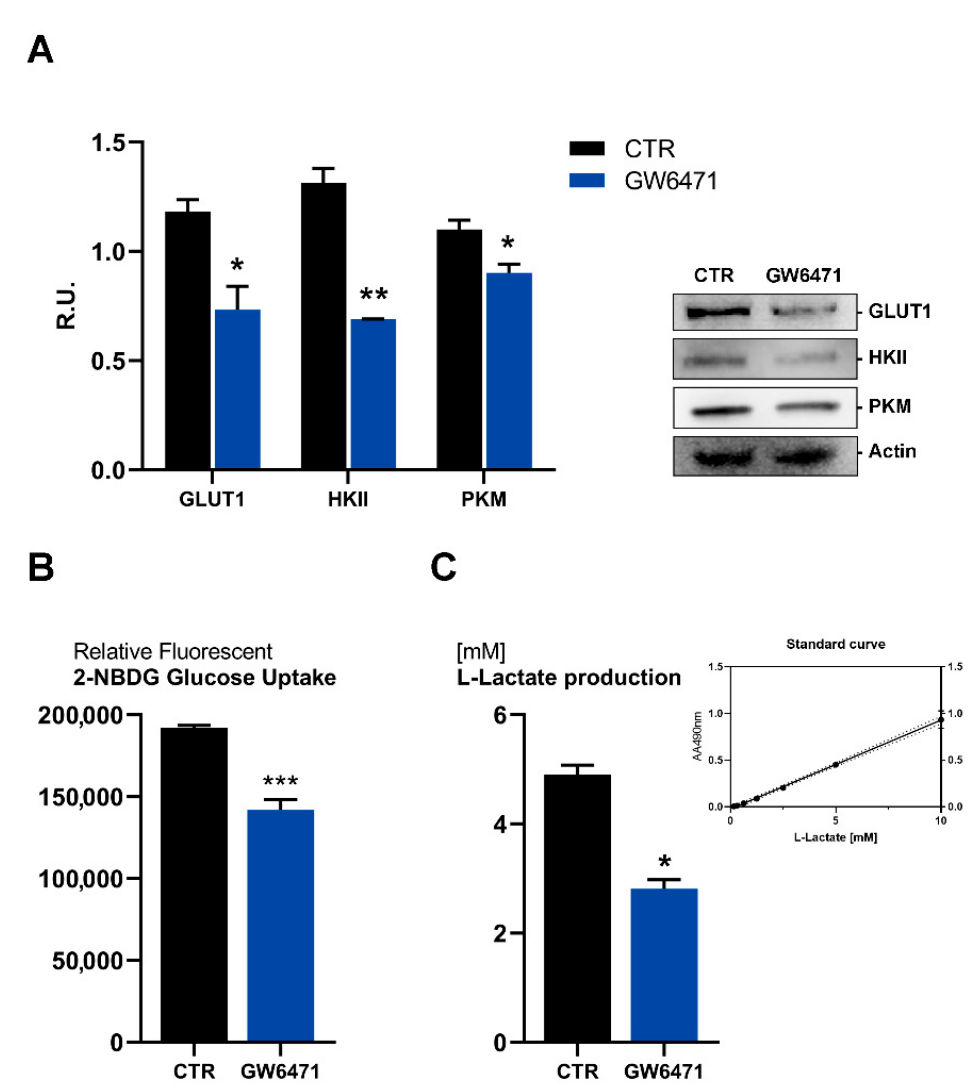
Figure 4. ( A ) Western blotting analyses for GLUT1, HKII, PKM in control and treated mammospheres. A representative western blot image is shown. ** p < 0.005; * p < 0.05 vs. CTR ( n = 3). ( B ) Glucose uptake analyses with the fluorescent tracer 2-NBDG. *** p < 0.0005 vs. CTR ( n = 3). ( C ) L-lactate production in control and treated mammospheres analyzed by Glycolysis Cell-Based Assay Kit. * p < 0.05 vs. CTR ( n = 3). The standard curve obtained in the assay is shown.